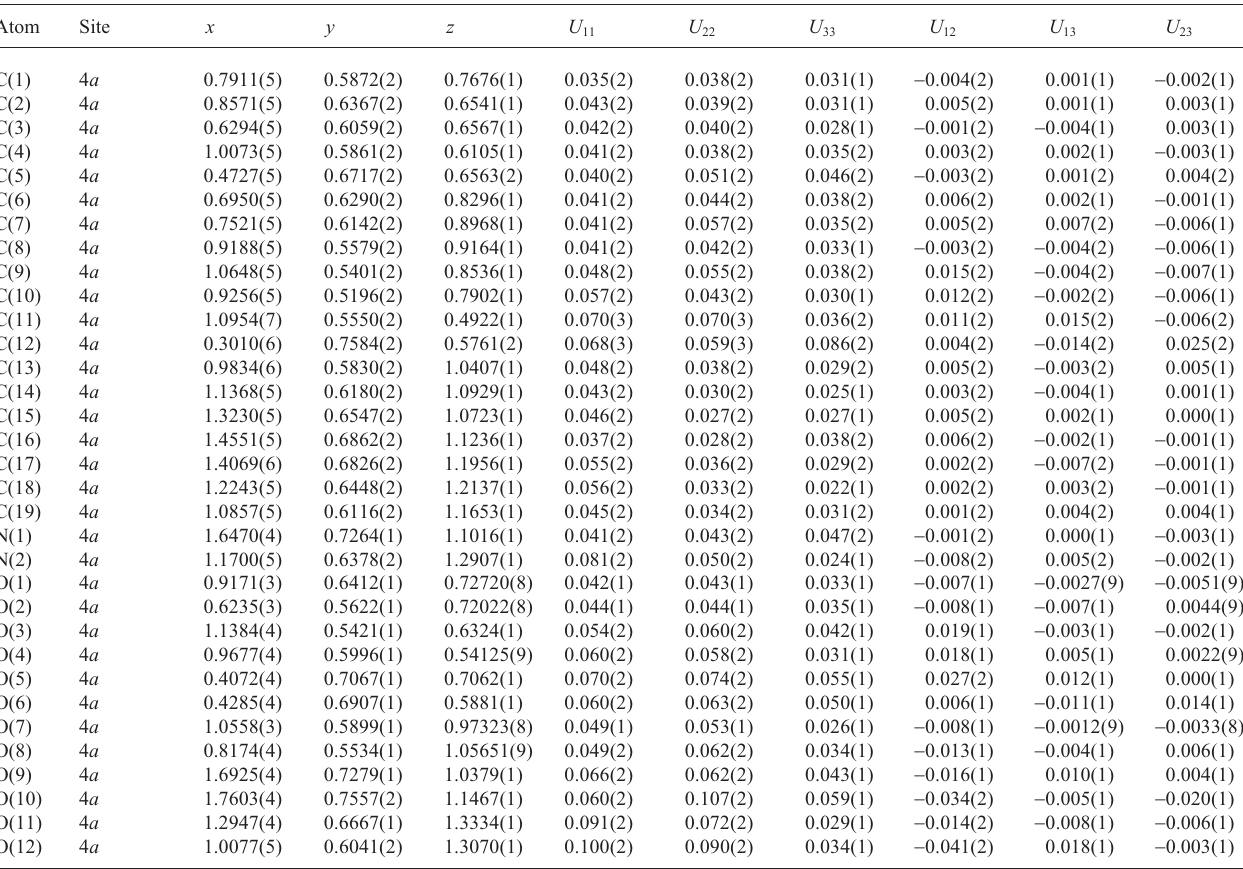
Table 3. Atomic coordinates and displacement parameters (in Å 2 )